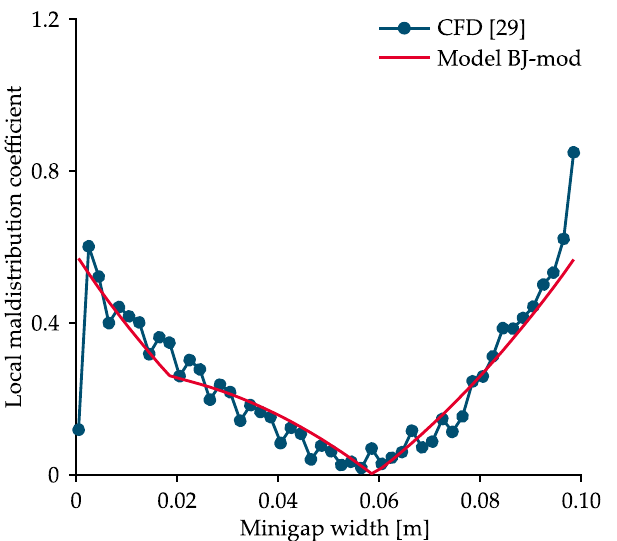
Figure 17. Comparison of the analytical (Model BJ-Mod) and numerical data (taken from the literature): ( a ) the first system configuration (header depth of 1 mm), momentum coefficients for flow in the distributor—1.10, collector—3.10; ( b ) the third system configuration (header depth of 8 mm), momentum coefficients for flow in the distributor—1.00, collector— 2.65.